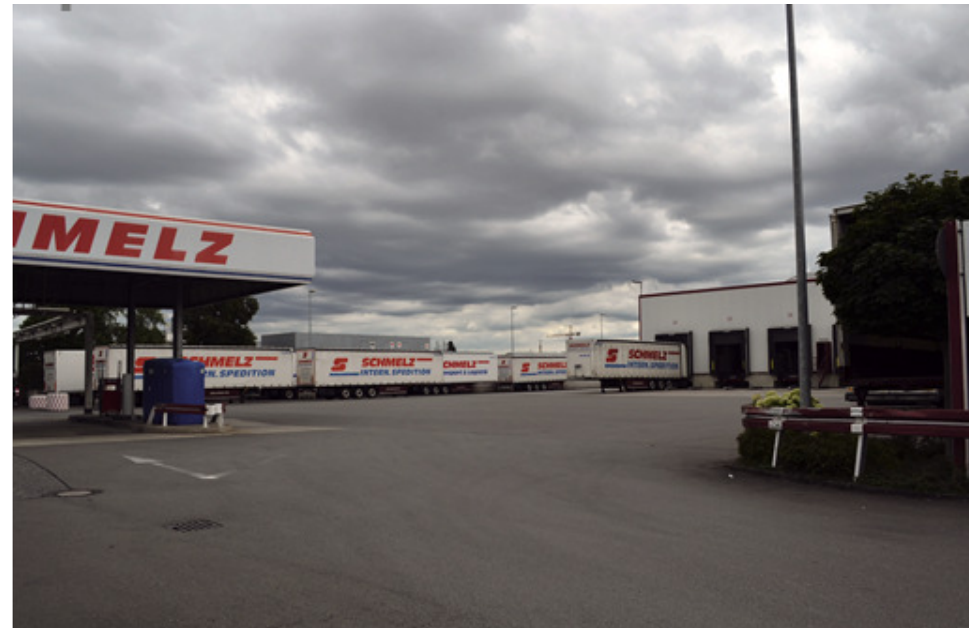
Figure 4. Kassel‐Waldau industrial area. Source: Charlotte